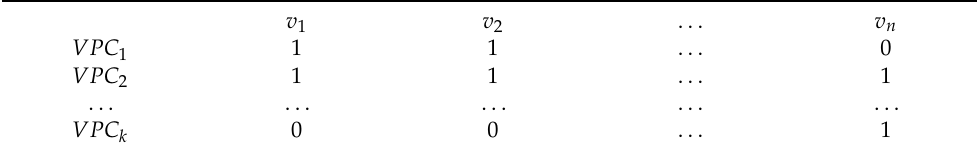
Table 1. Vertex visibility matrix.